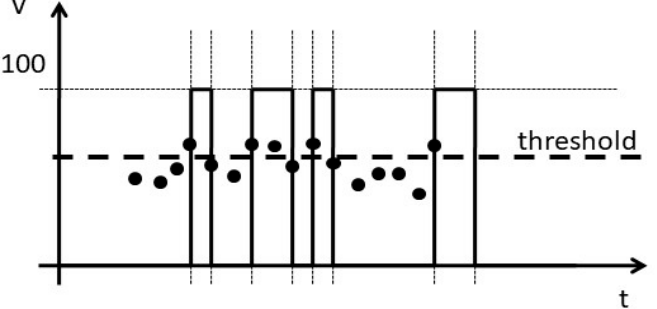
Figure 2. Measured value that exceeds the threshold: False detections in the presence of noise.